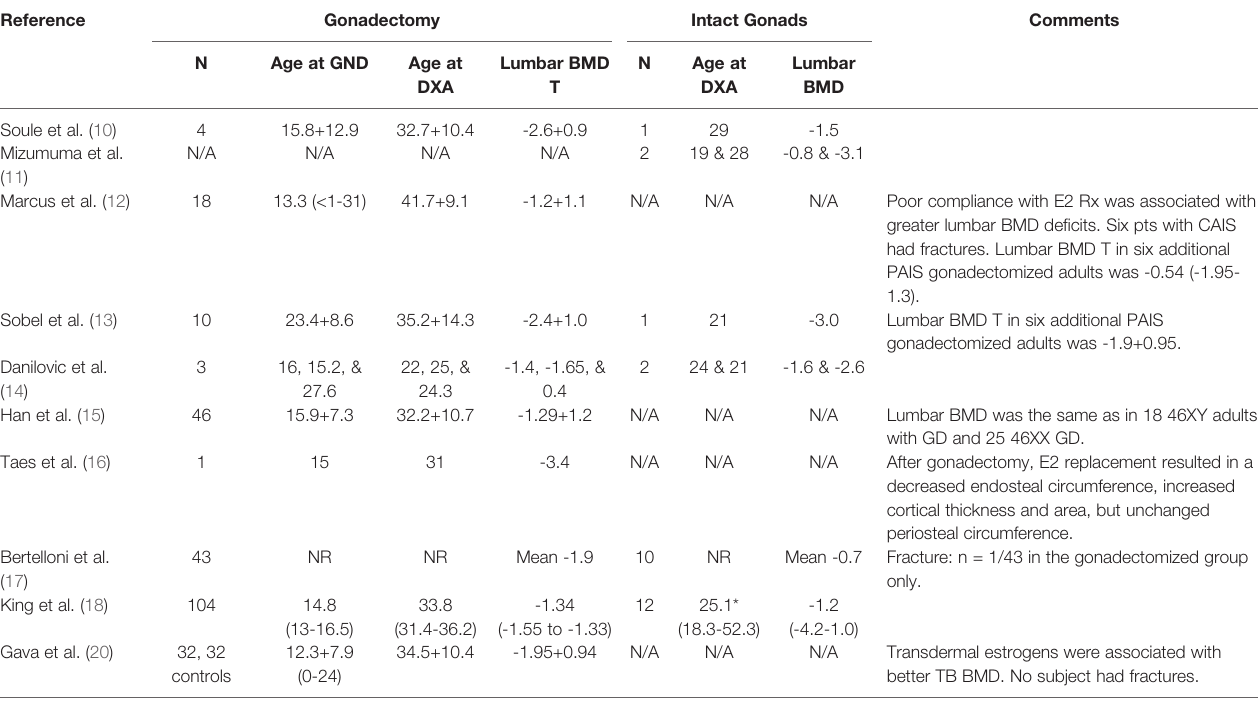
GND, gonadectomy; NR, not reported; T, T-score; TB, total body; GD, gonadal dysgenesis; N/A, Not Available. *refers to the age of gonadectomy with DXA performed shortly before gonadectomy.